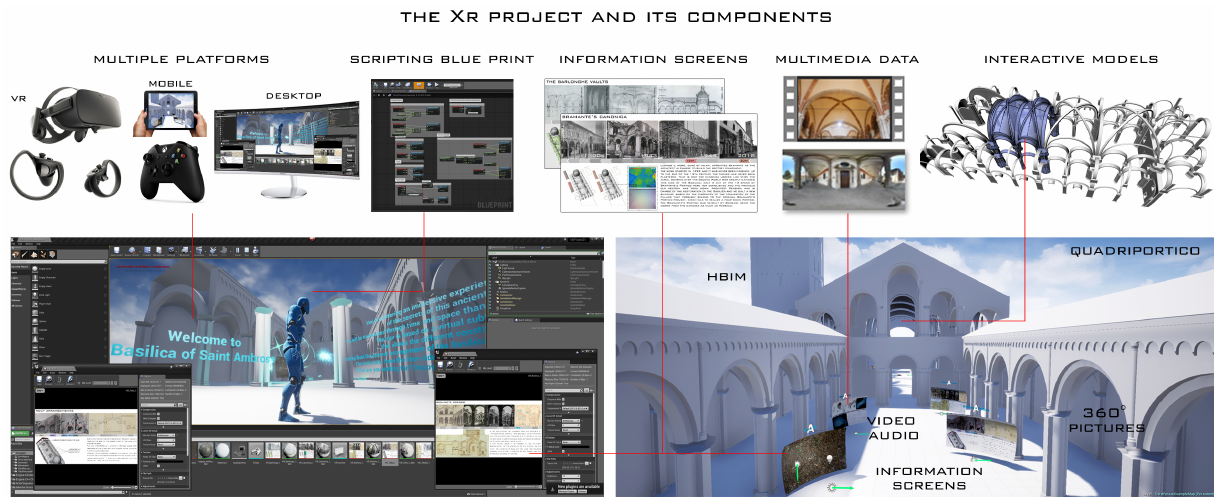
Figure 8. The Xr project has provided for the different data sources such as information screens, multimedia data and an interactive model .